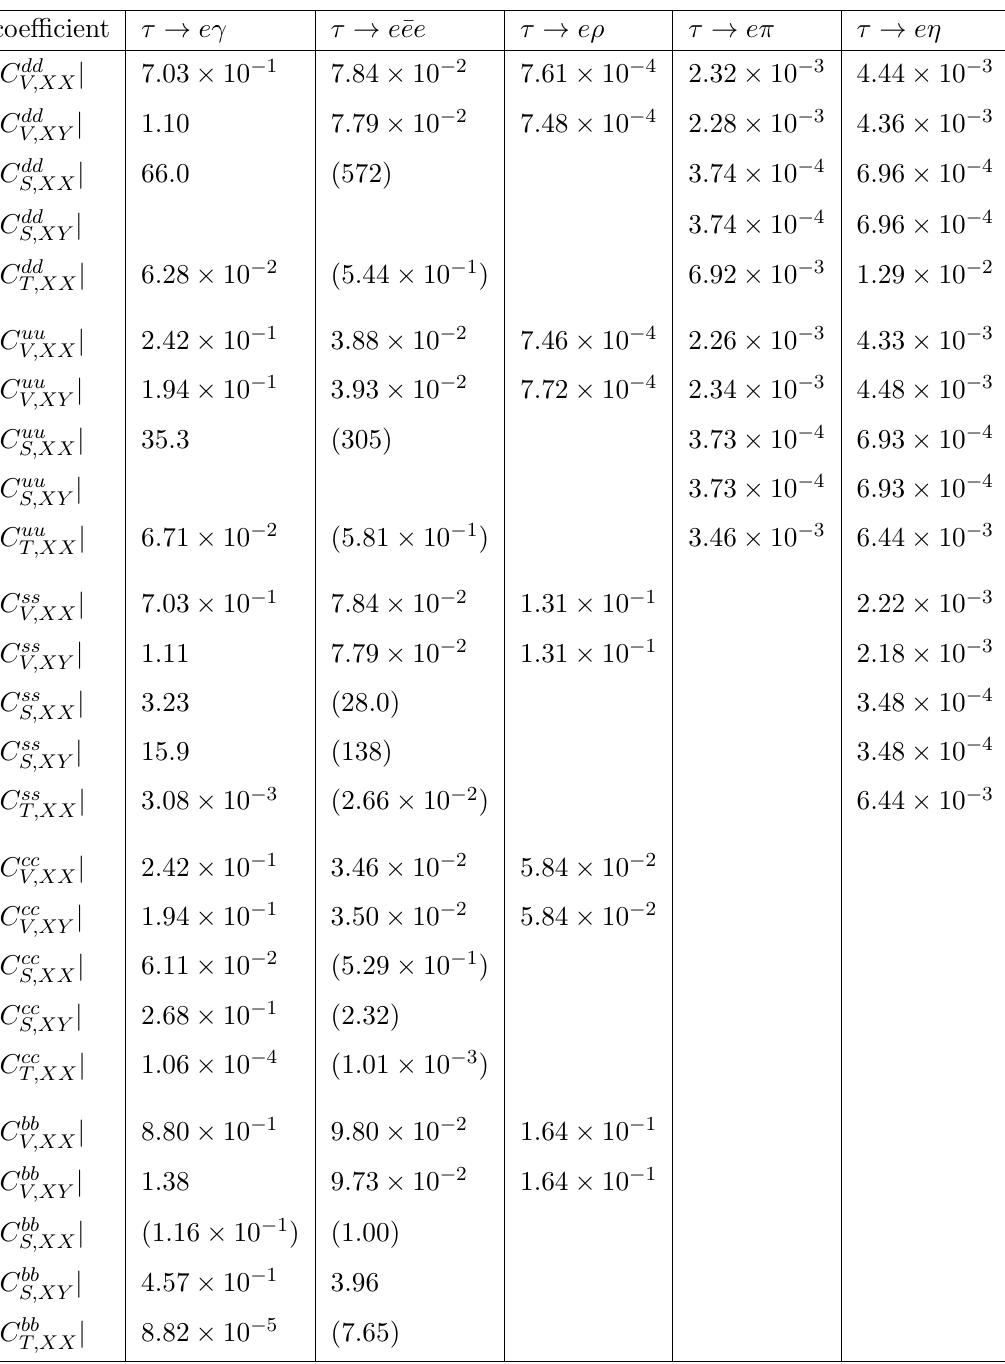
Table 9 . Similar to table 8, but for 2-lepton-2-quark